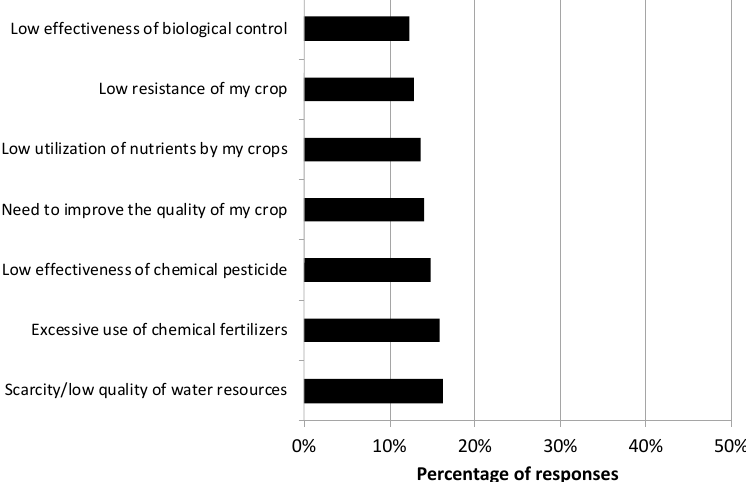
Figure 6. Farmers’ knowledge of microalgae’s capacity to mitigate environmental barriers in Almer í a’s greenhouse horticulture.